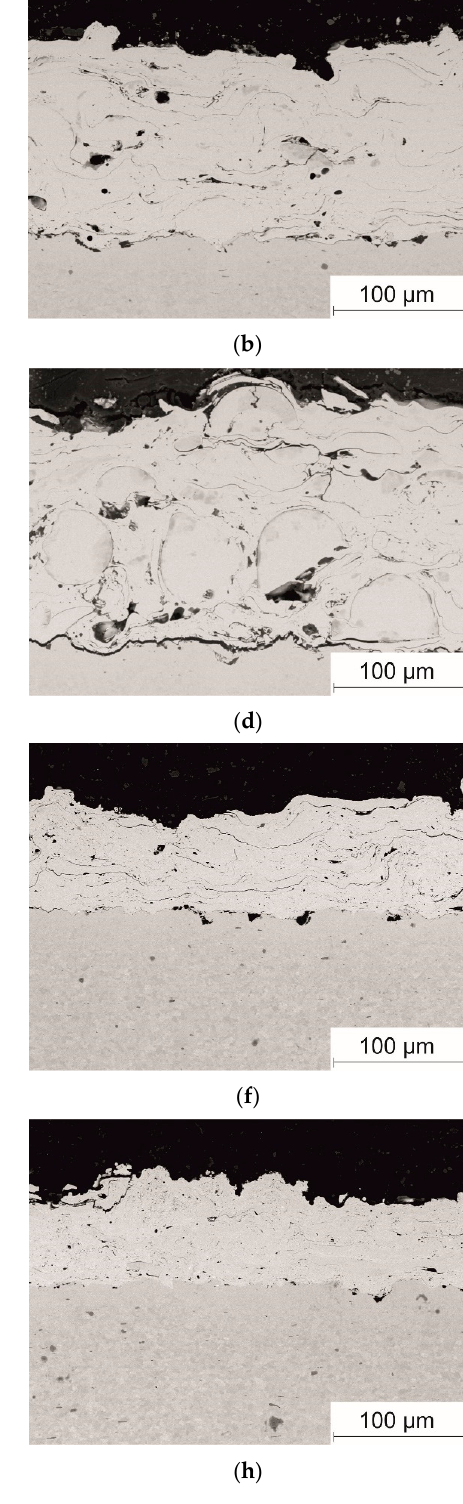
Figure 6. Cross-sections of the Fe 66 Cr 10 Nb 5 B 19 detonation coatings obtained at different explosive charges: ( a ) 35%; ( b ) 40%; ( с ) 45%; ( d ) 50%, ( e ) 55%; ( f ) 60%; ( g ) 65%; ( h ) 70%.